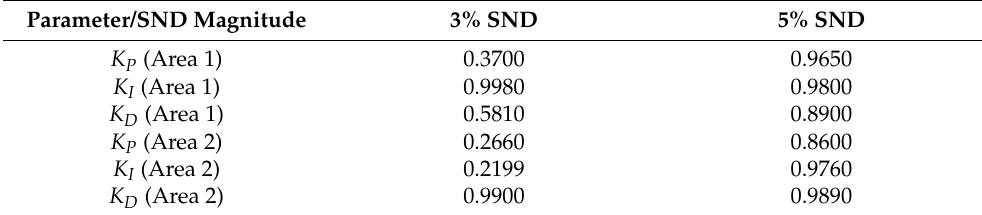
Table 5. The SAO-PID gains at different magnitudes of